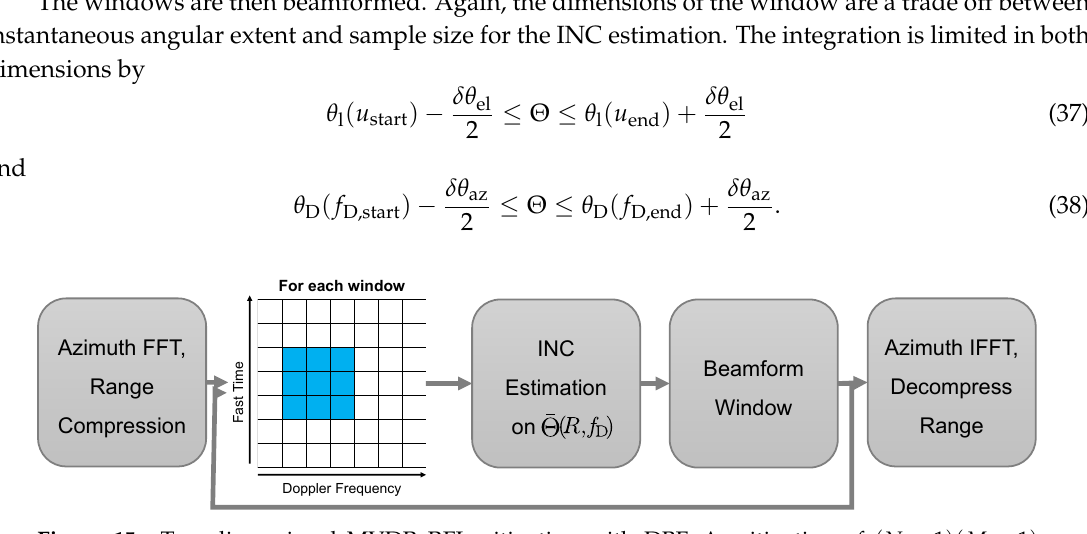
Figure 15. Two-dimensional MVDR RFI mitigation with DBF. A mitigation of ( N − 1 )( M − 1 ) interferers per window is